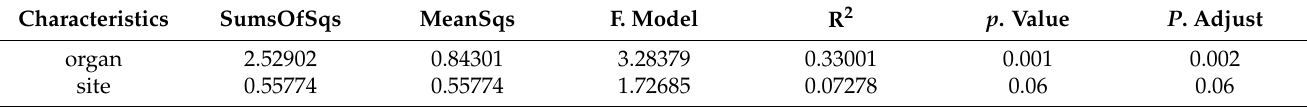
Table 3. PERMANOVA analysis of endophytic fungal flora of S. alopecuroides.